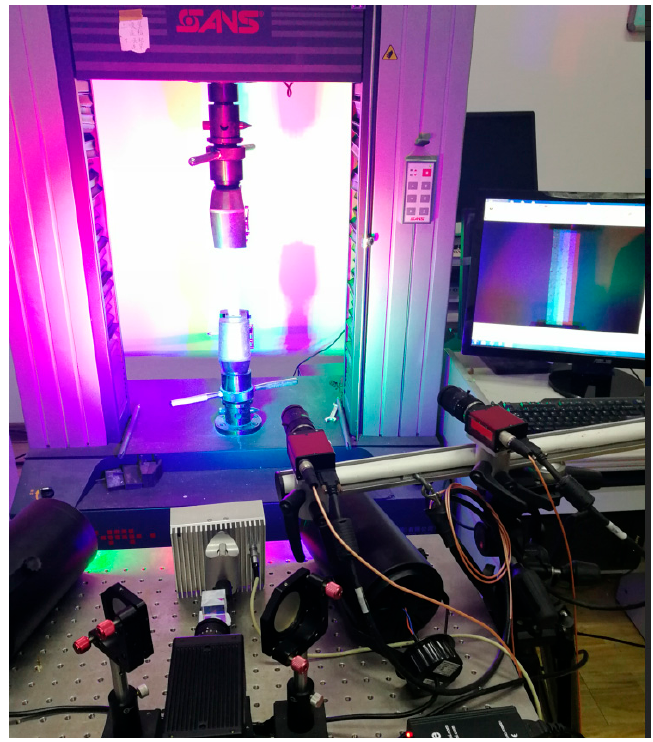
Figure 11. The setup for the strain test.